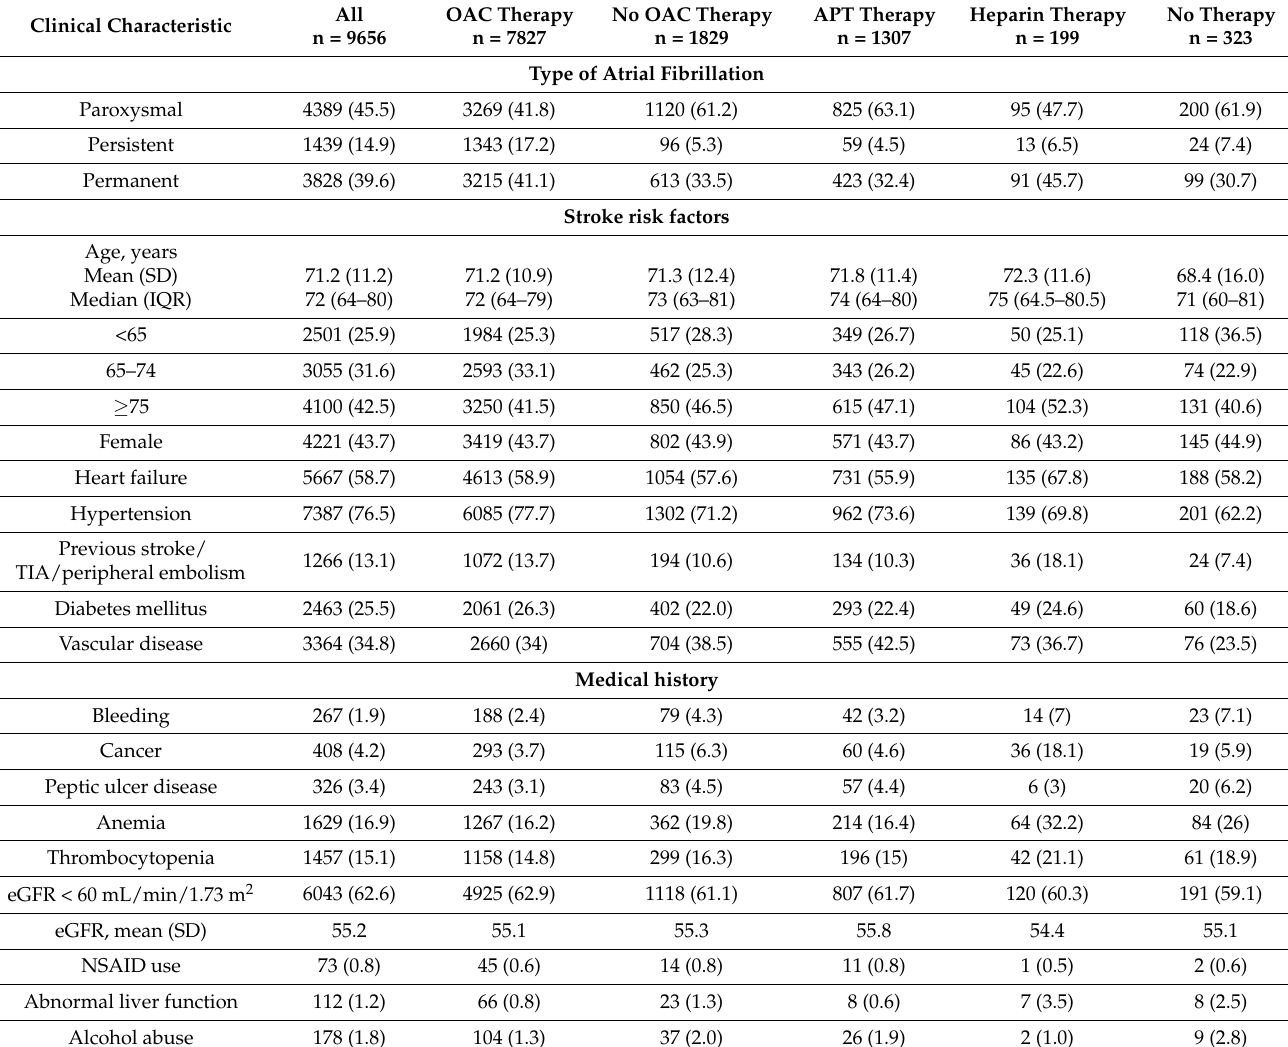
Table 1. Baseline characteristic of the study group according to stroke